Question: What kind of plot is shown here?
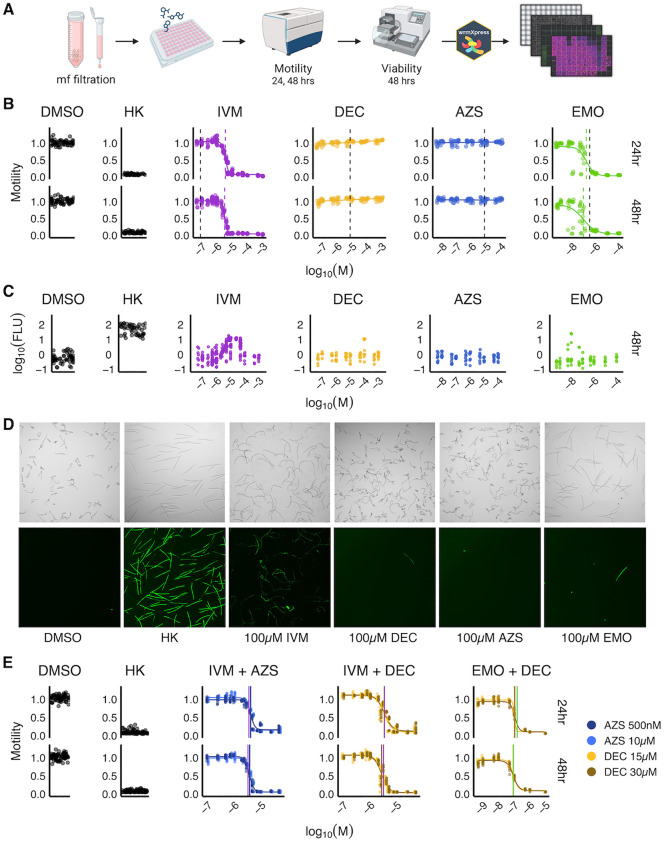
Answer: line